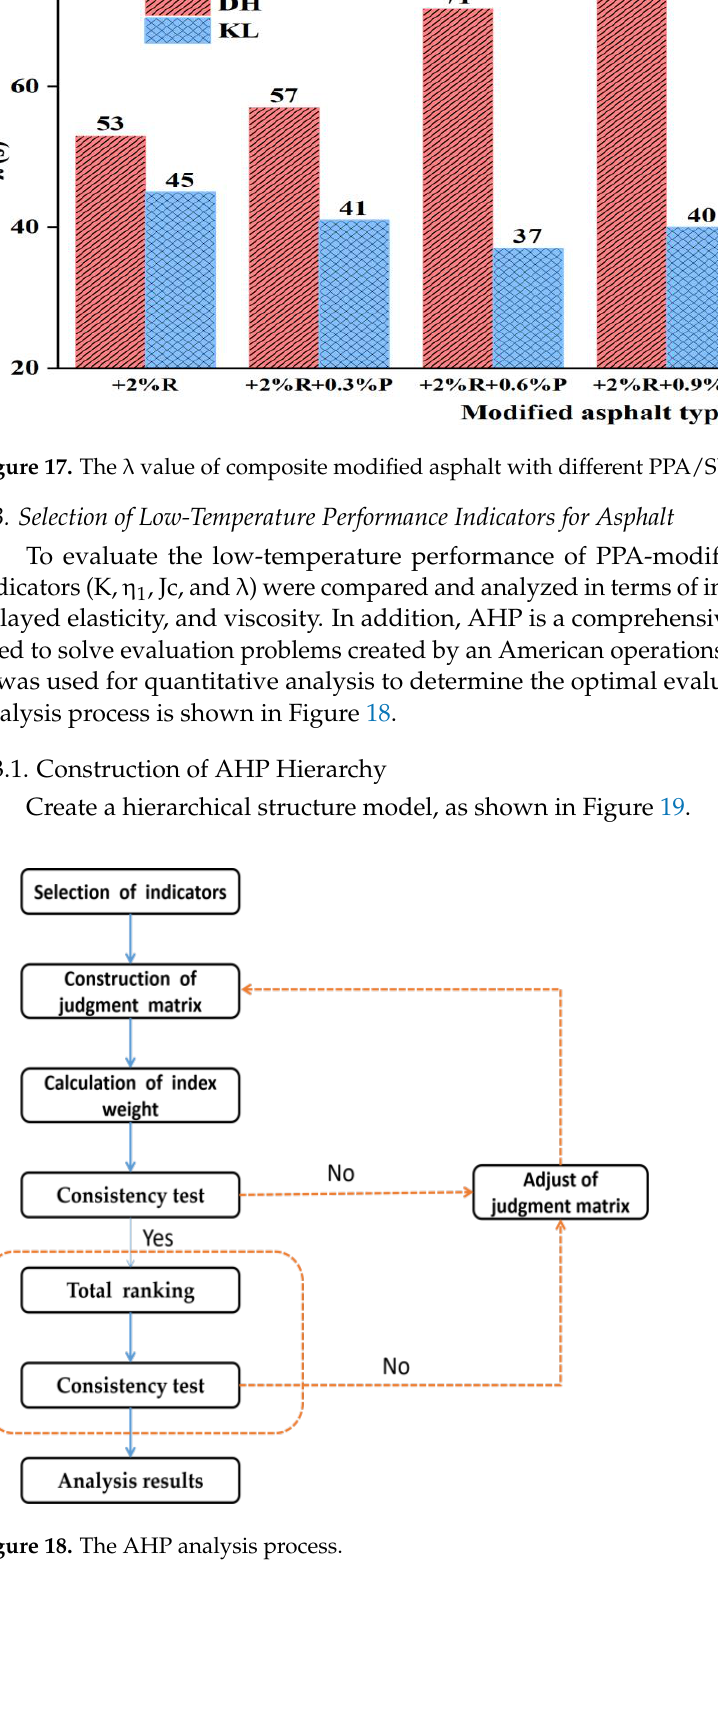
Figure 19. AHP hierarchy. 3.3.2. Construction of the Judgment Matrix A for the Goal and Criterion Layers and Consistency Test